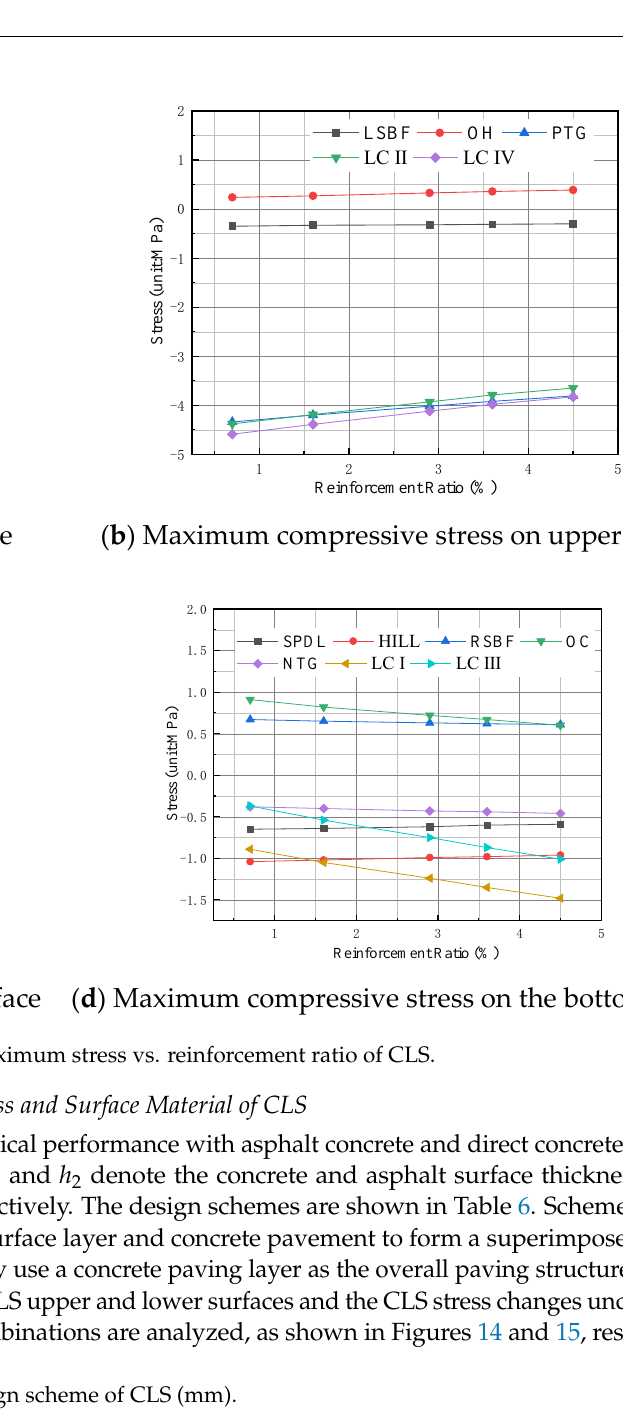
Table 6. Thickness design scheme of CLS (mm).